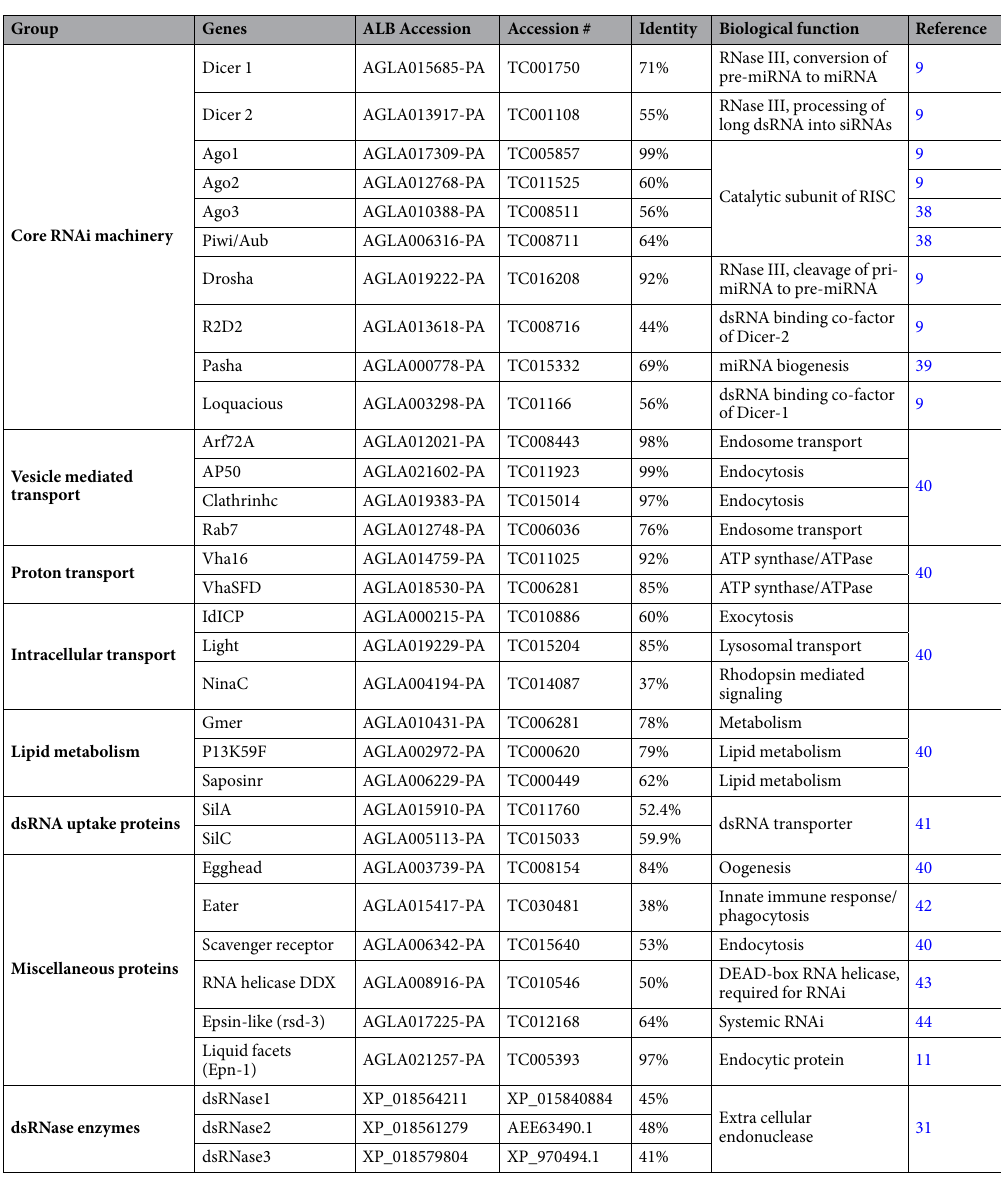
Table 1. RNAi genes identified in the genome of A. glabripennis and their predicted biological